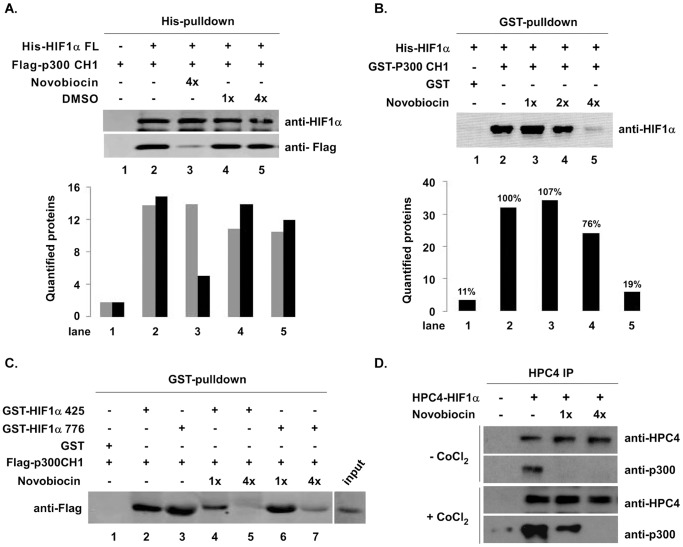
Novobiocin directly disrupts the HIF1αCTAD/p300 CH1 complex.
A. Novobiocin inhibits His-HIF1α FL protein pulling down p300 CH1. Insect cell expressed and purified His-HIF1α FL (∼5 µg), Flag-p300 CH1, 400 µM of antibiotic novobiocin or DMSO (control), and 15 µl of Ni2+-agarose were mixed in binding buffer containing 40 mM Hepes-NaOH (pH 7.9), 250 mM NaCl, 10% glycerol, and 40 mM imidazol, and incubated at 4°C for 2 hours. Bound proteins were eluted with 20 µl of elution buffer containing 300 mM imidazol and were then confirmed by Western blotting with anti-HIF1α and anti-Flag antibodies (upper panel). Western blot images were quantified using Quantity One software (BioRad) (lower panel). B. Novobiocin inhibited GST-p300 CH1 protein pulling down the HIF1α FL. GST-p300 CH1 protein (∼10 µg GST only as a negative control) was mixed with His-HIF1α FL, 15 µl of glutathione sepharose 4 Fast Flow beads, and novobiocin (100–400 µM). Bound proteins were then detected by Western blotting with anti-HIF1α antibody. Quantified HIF1α is depicted in the graph (lower panel). Percentages given above each bar represent bound HIF1α protein compared to lane 2. C. Novobiocin directly disrupts the HIF1α CTAD/p300 CH1 complex. The GST pull-down assay was performed by mixing (as indicated in the figure) ∼10 µg GST fusion proteins, 5 µg Flag-p300 CH1, and 100 or 400 µM novobiocin. Pulled-down p300 CH1 was detected by Western blotting with anti-Flag antibody. D. Novobiocin inhibited the interaction between overexpressed HIF1α FL and endogenous p300 in the presence or absence of CoCl2. HPC4-HIF1α FL was overexpressed in HeLa cells in the presence or absence of novobiocin (100 or 400 µM). Hypoxic conditions were induced by the addition of CoCl2 (150 µM) for 8 hours. Then, 50 µM MG132 was added 3 hours before harvest. At 72 hours after HPC4-HIF1α transfection, cells were harvested and an HPC4 immunoprecipitation assay was performed by mixing 250 µl whole-cell lysate, 2 µg HPC4 antibody, and 15 µl of glutathione sepharose. Bound p300 was then detected by Western blotting with anti-p300 antibody.